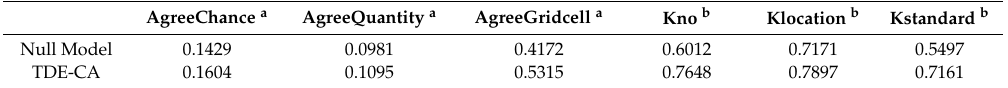
Table 4. Comparison of the null model and the TDE-CA.